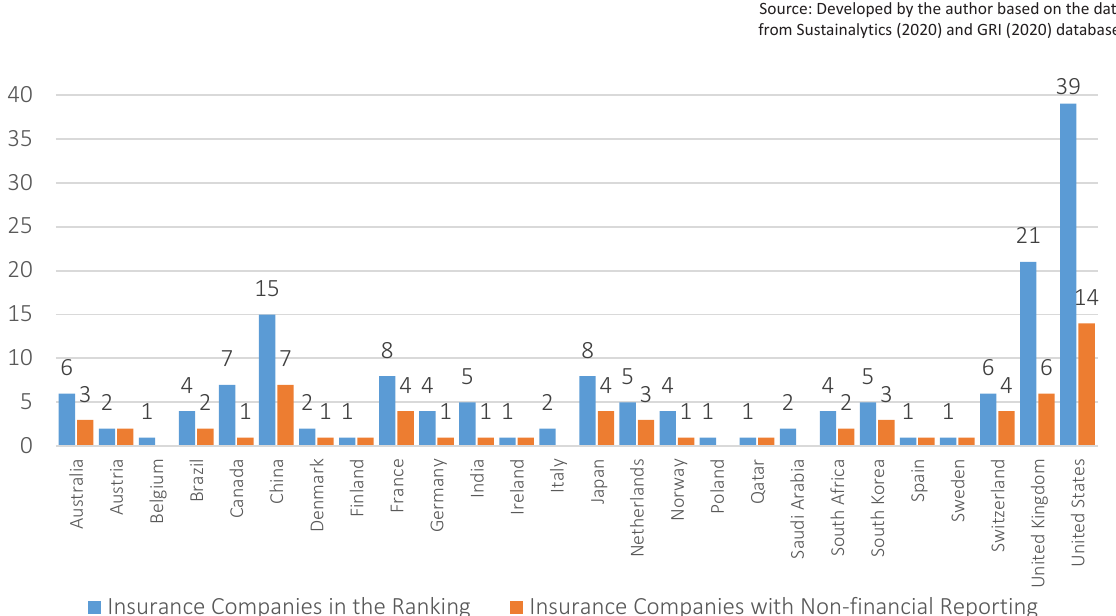
Figure 2. Number of insurance companies from Company ESG Risk Ratings that provide non-financial reporting to the GRI database